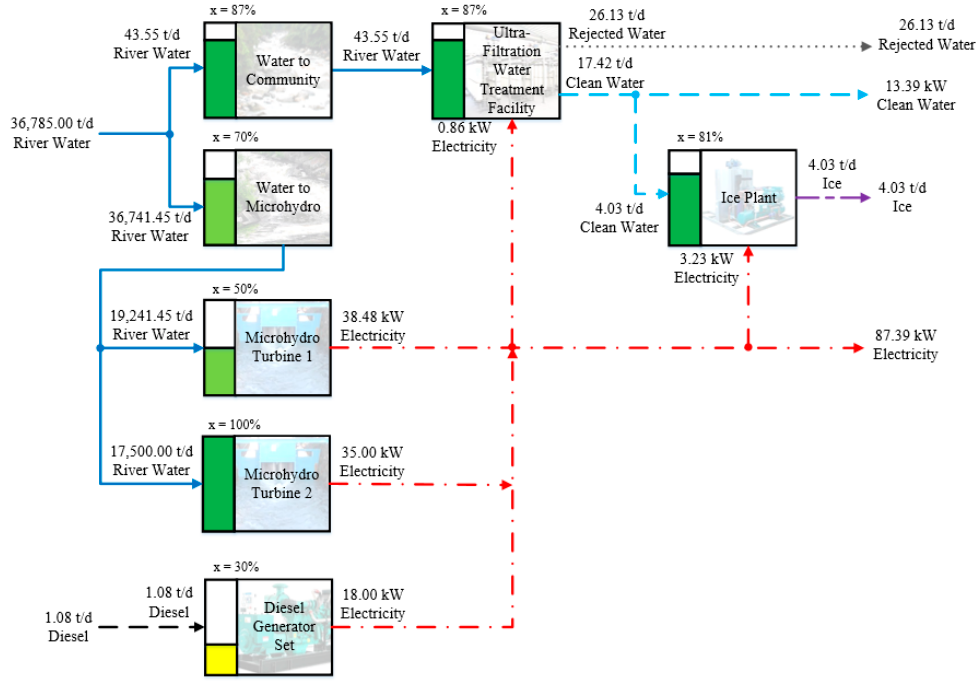
Figure 9. The optimal configuration of the polygeneration system of case study 3 under D = 0.30 (or 30%).